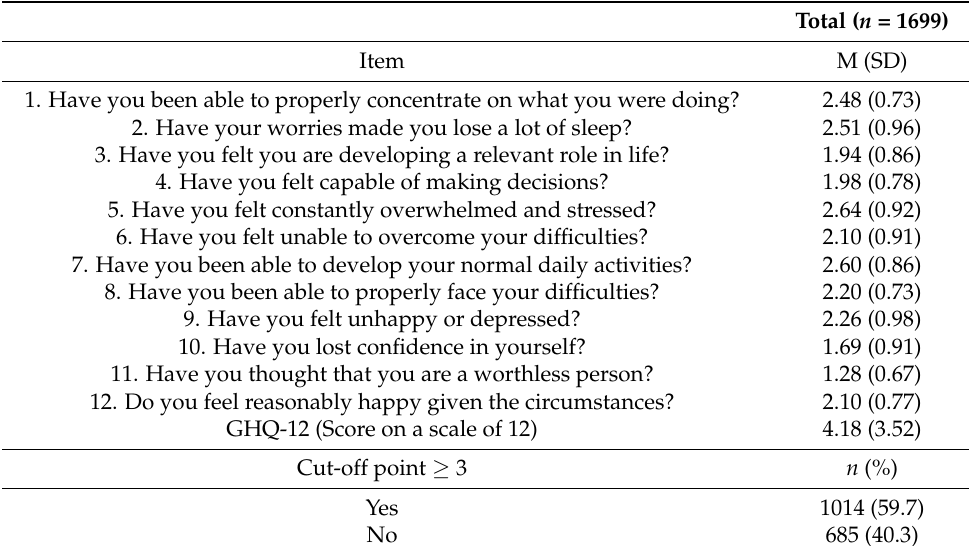
Table 2. Psychological Distress: General Health Questionnaire